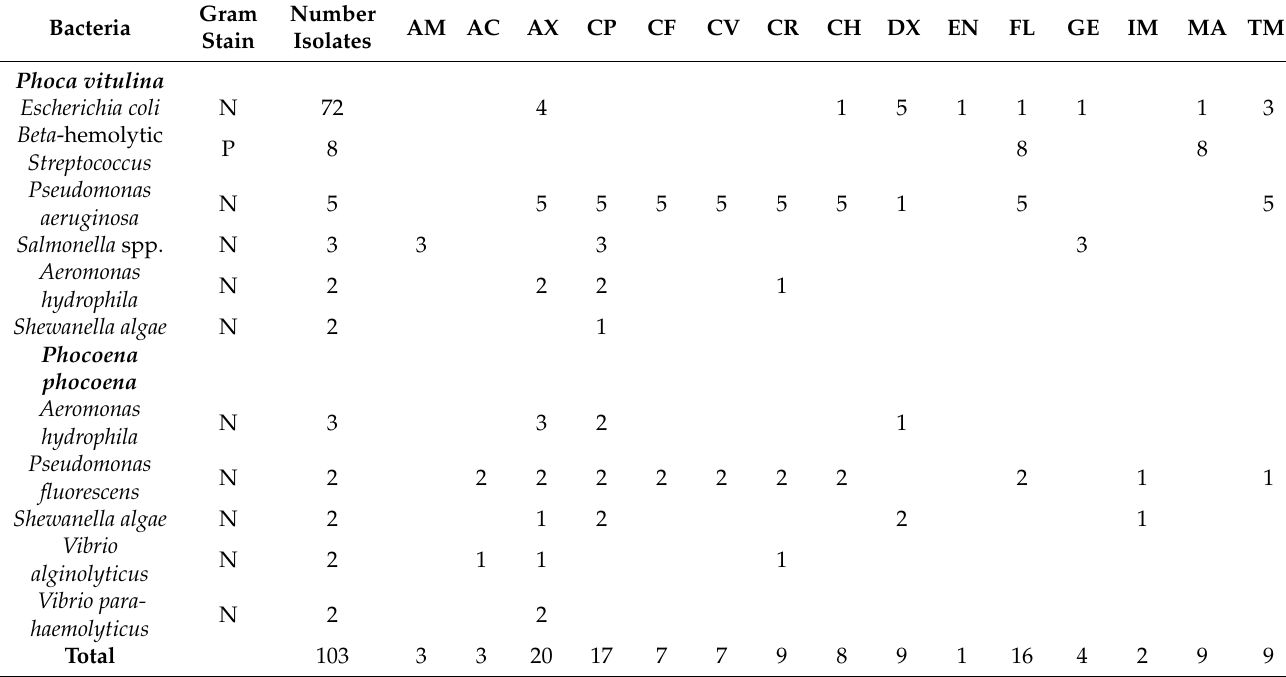
AM = Amikacin, AC = Amoxicillin/clavulanic acid, AX = Amoxicillin, CP = Cephalexin, CF = Cefpodoxime, CV = Cefovecin, CR = Ceftiofur, CH = Chloramphenicol, DX = Doxycycline, EN = Enrofloxacin, GE = Gentamicin, FL = Florfenicol, IM = Imipemem, MA = Marbofloxacin, TMS =